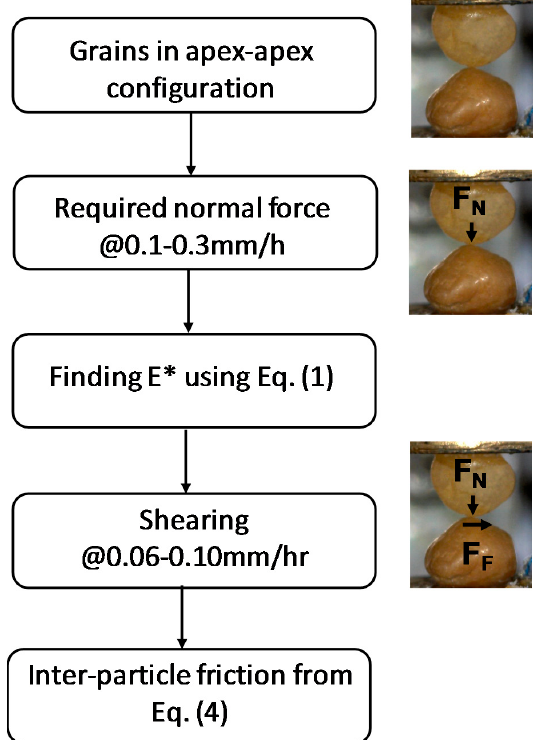
Figure 2. Flowchart showing the methodology used to derive inter-particle friction from present experiments.